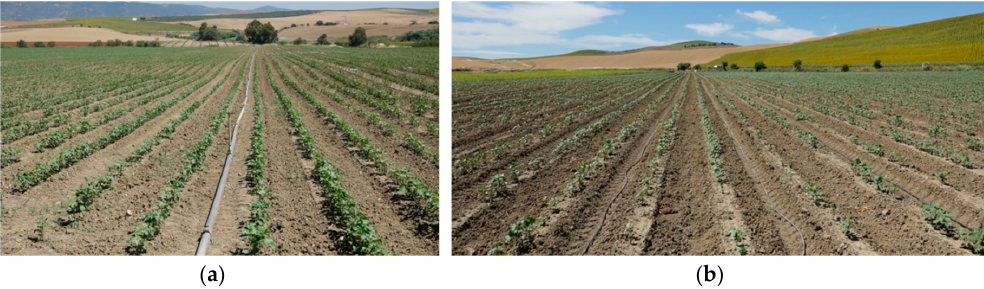
Figure 2. General view of the two studied cotton crops in the early stage: ( a ) C1–16, ( b ) C2–16.